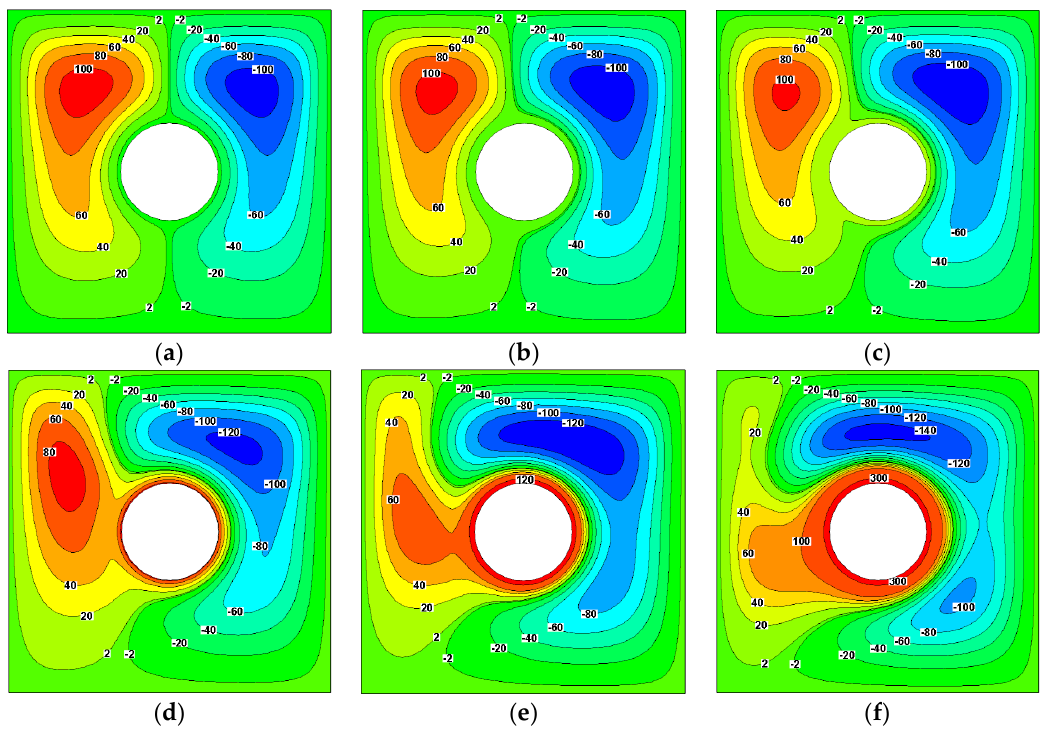
Figure 9. ( a ) N = 0, ( b ) N = 10, ( c ) N = 20, ( d ) N = 50, ( e ) N = 100, ( f ) N = 200. Contours of dimensionless temperature at λ = 0.4, Ha = 40 and Ra = 10 6 .